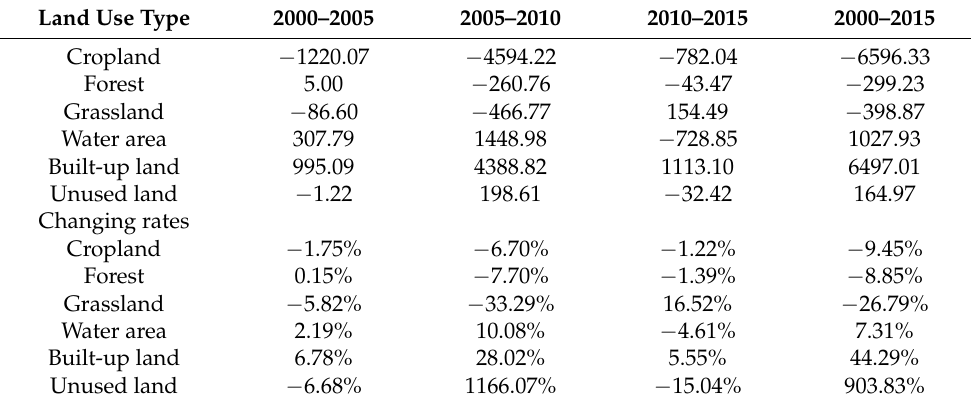
Table 3. Land use area changes between typical years (km 2 ).